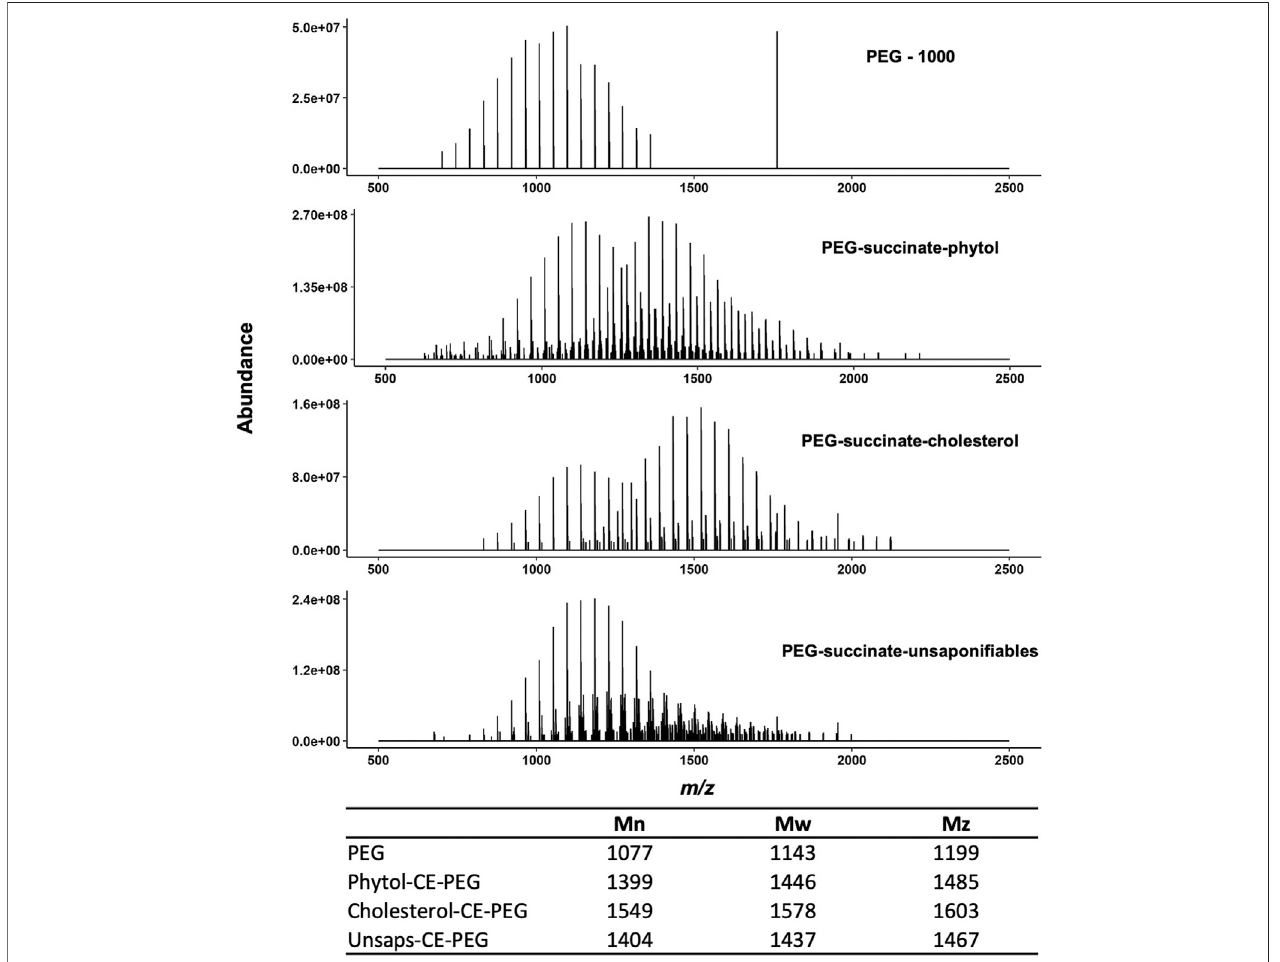
FIGURE 5 | Summary of MALDI-FT-ICR-MS of surfactants synthesized from phytol, cholesterol, and S. acutus unsaponi fi ables. Top to bottom are PEG 1000, phytol-SA-PEG, cholesterol-SA-PEG, and unsaponi fi ables-SA-PEG. Bimodal distributions are observed in the reacted surfactant samples, where the lower m/z distribution corresponds tounreacted PEG 1000. Therespective calculated molecular weight distribution isincluded;Mn (cid:1) number average,Mw (cid:1) weight average,and Mz (cid:1) Z average.